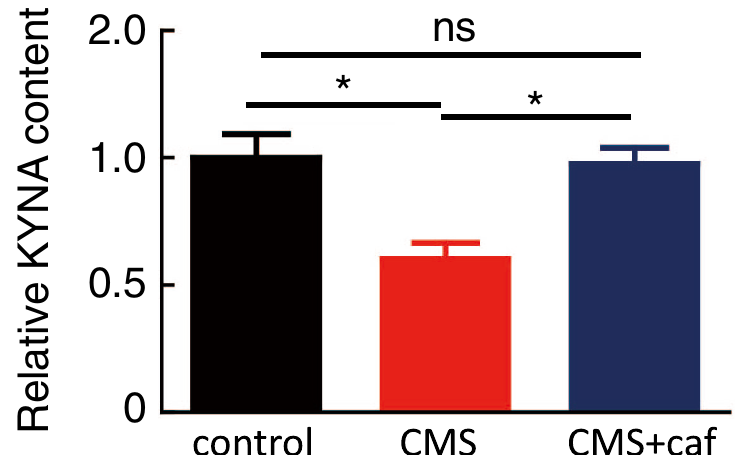
administration enhanced Pgc-1α levels in the skeletal muscle of CMS-exposed mice (Fig. 3a; Supplementary data). IDO1, IDO2, TDO1, and TDO2 are rate-limiting enzymes in the kynurenine pathway 13,14 . The RT-qPCR results indicated that Ido2 , Tdo1 , and Tdo2 transcript levels were upregulated in the skeletal muscle of CMS- exposed mice compared to those of the control mice (Fig. 3d). However, when CMS-exposed mice were treated